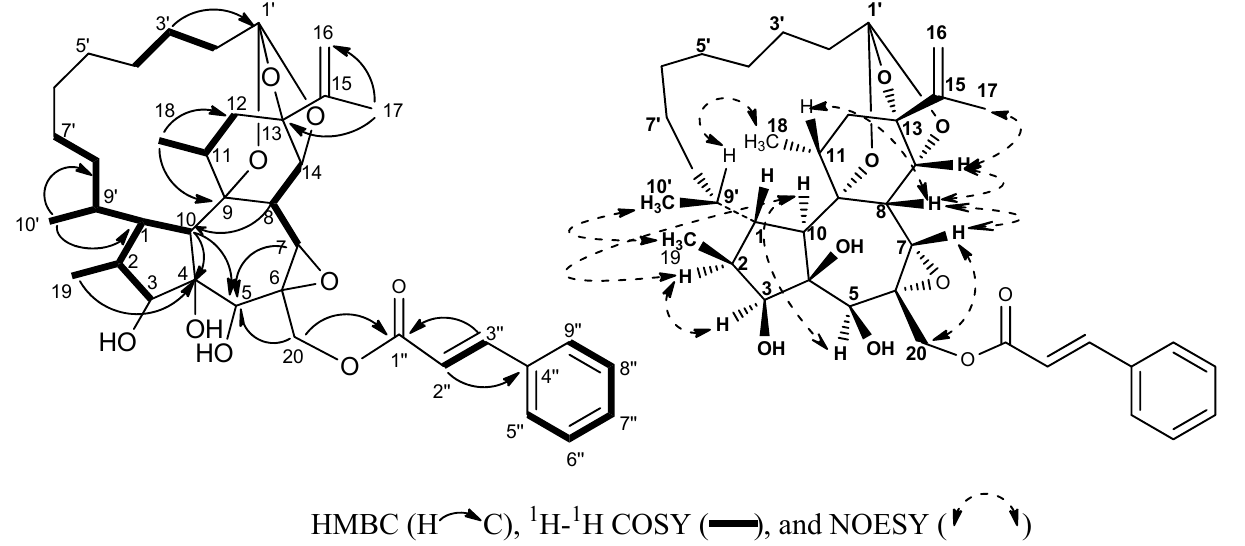
Figure 2. Key HMBC, 1 H- 1 H COSY and NOESY of compound 1